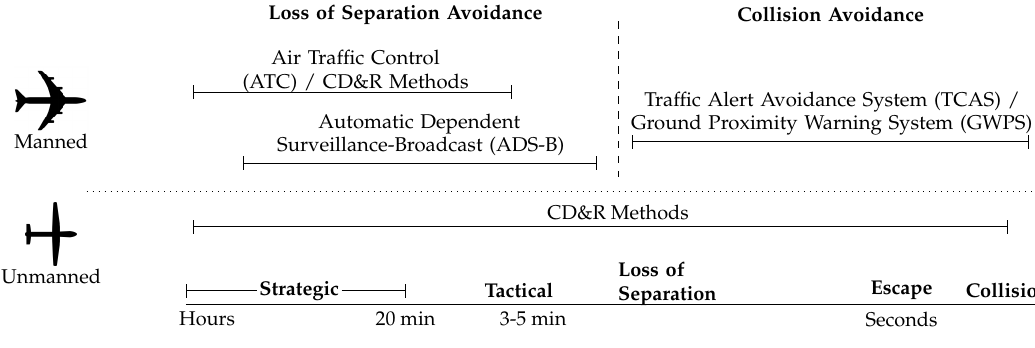
Figure 3. Conflict detection and resolution methods for manned and unmanned aviation per look-ahead